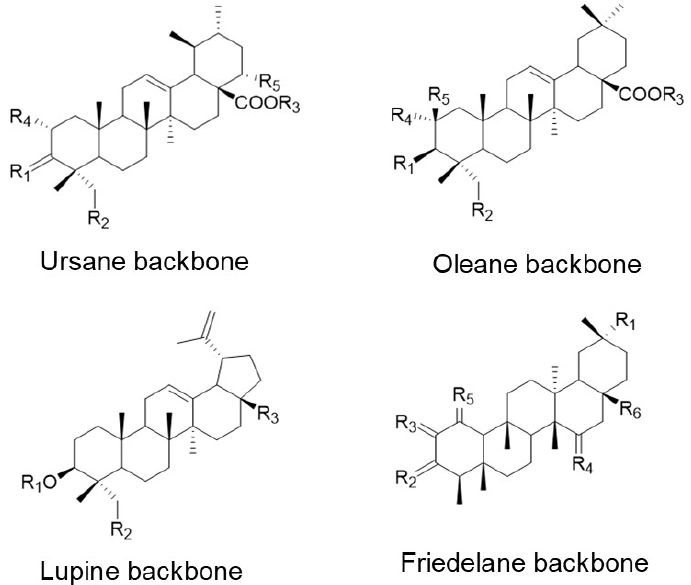
Figure 1. Four basic ring skeletons of pentacyclic triterpenoids. Ursolic acid (UA) is a pentacyclic triterpenoid primarily synthesized through the MVA pathway, similar to steroid hormones in plants and mammals [4]. UA is found in the protective, waxy coating of apples and other fruits [11–13]. This review focuses on UA and